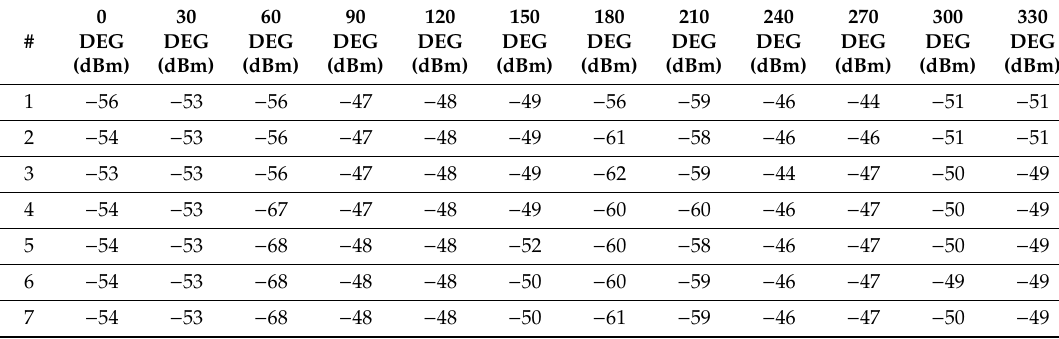
Table 3. RSSI measurements data.